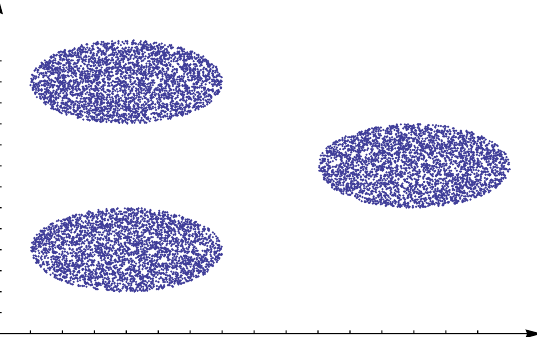
Figure 2. Synthetically generated ellipses in a Cartesian coordinate system ( x , y ) .